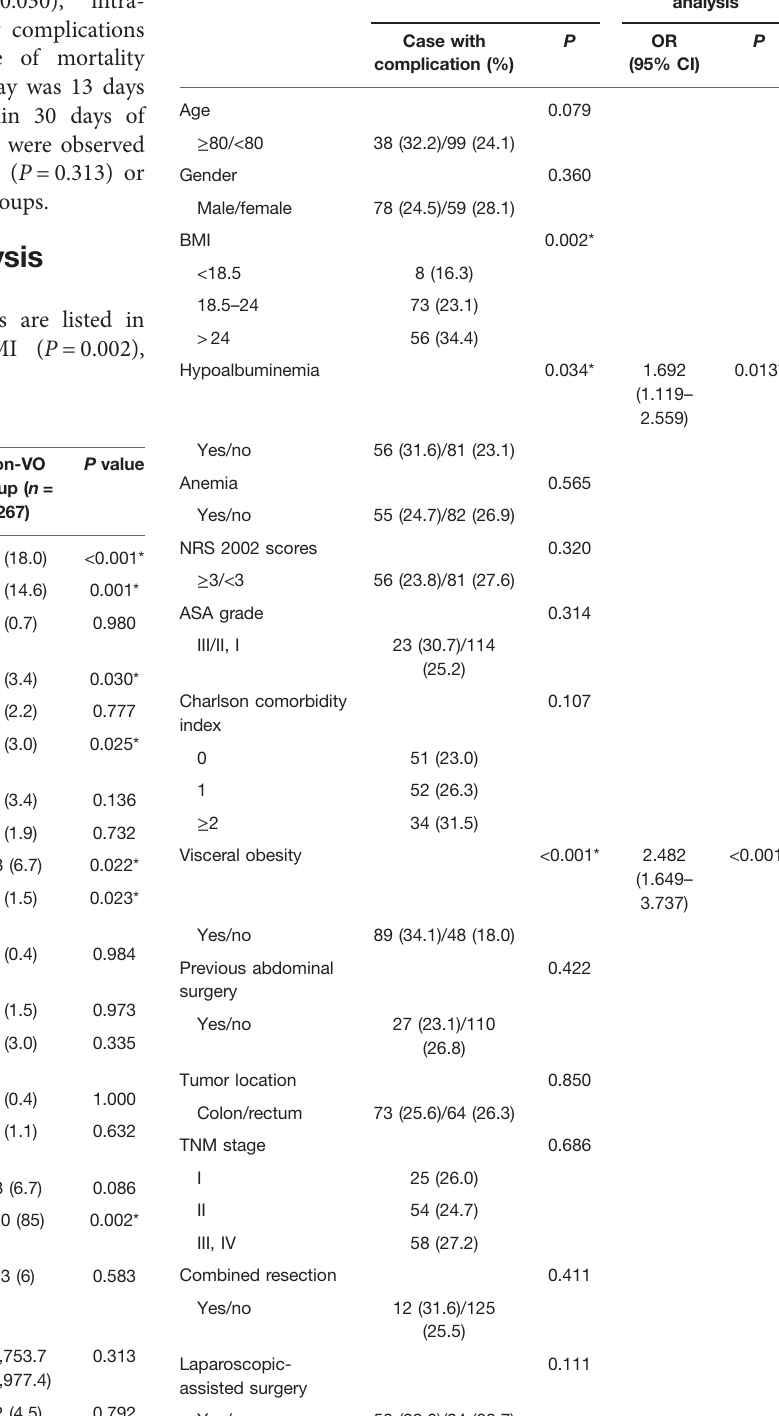
TABLE 3 | Univariate and multivariate logistic regression analysis of risk factors for total complications. Factors